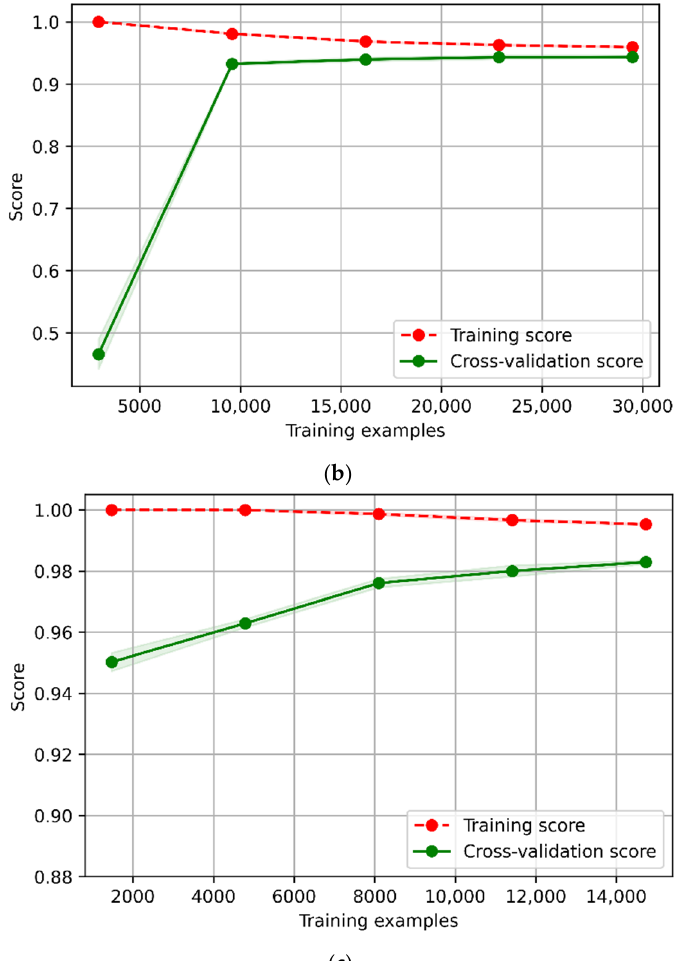
Figure 13. Learning curves for 5-fold cross-validation of three models (with the best performance on three different time windows) on the three-axis acceleration and gyroscope data training set. ( a ) Learning curve of stacking by 5-fold cross-validation on 3 s time window; ( b ) learning curve of ELM by 5-fold cross-validation on 5 s time window; ( c ) learning curve of ELM by 5-fold cross-validation on 11 s time window.